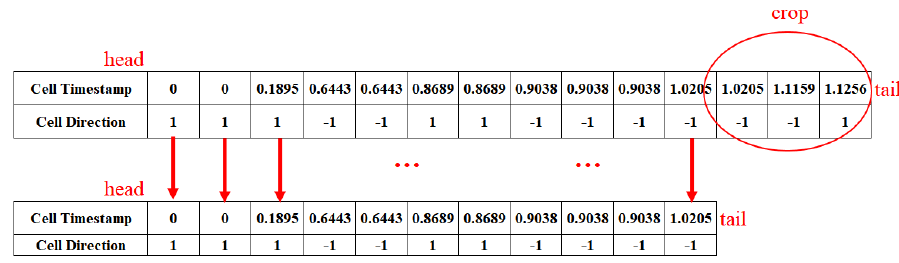
Figure 11. Data augmentation (crop on data).